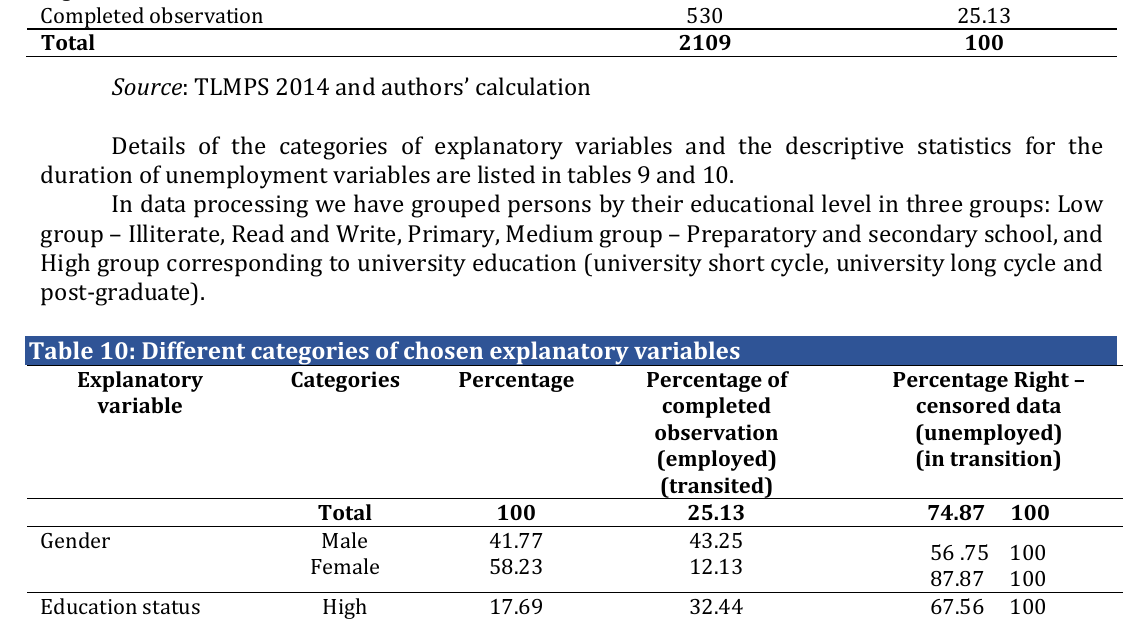
Table 9 : Employment status of unemployed individuals Right – censored data